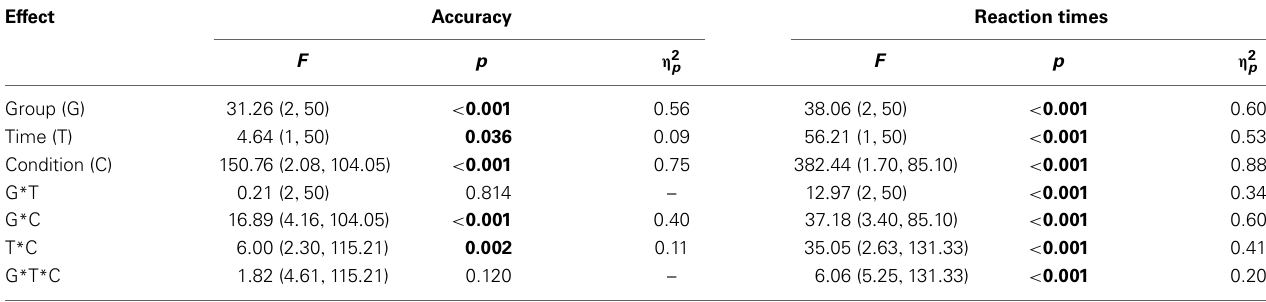
Table 6 | Results of the ANOVAs for repeated measures with F -values (df), p -values, and effect sizes η 2 p for the accuracy and reaction times of the behavioral task including the between-subject factor group (CON; IMP; NIMP) and the within-subject-factor time (pre; post) and condition (W; PH; PW; FF).